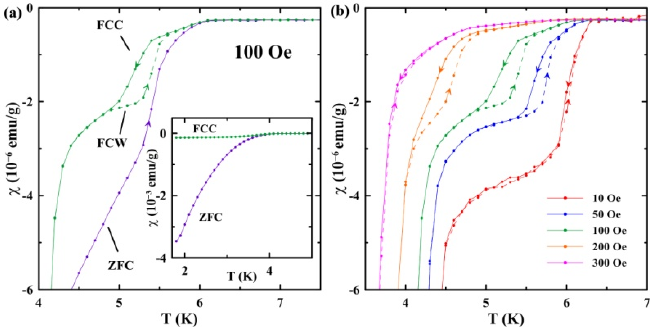
Figure 5. ( a ) Temperature dependencies of the FCC, FCW, and ZFC susceptibilities at 100 Oe near the superconducting transitions. The inset shows the total ZFC and FCC curves. ( b ) Temperature dependencies of the FCC (solid lines) and FCW (dashed lines) susceptibilities near the superconducting transitions at fields indicated in the panel. The arrows show the direction of changing temperature.